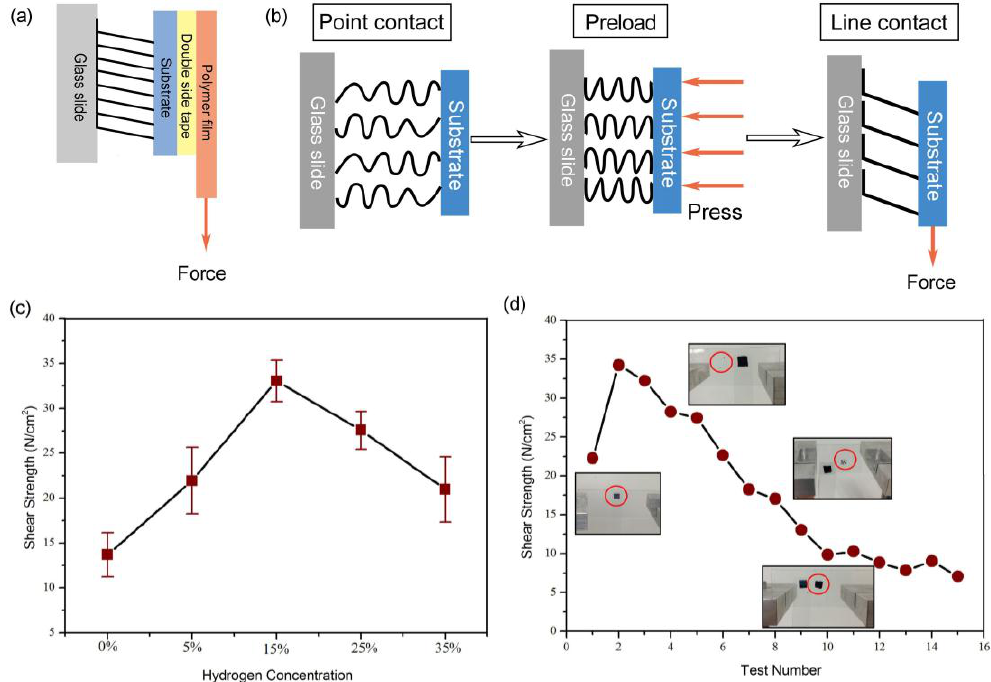
Figure 6. ( a ) The hanging-weight system to test the shear adhesive strength of VACNTs; ( b ) The schematic diagram of the shear adhesive strength test process; ( c ) The shear adhesive strength of VACNTs prepared under different hydrogen concentrations; ( d ) The shear adhesive durability of VACNTs.